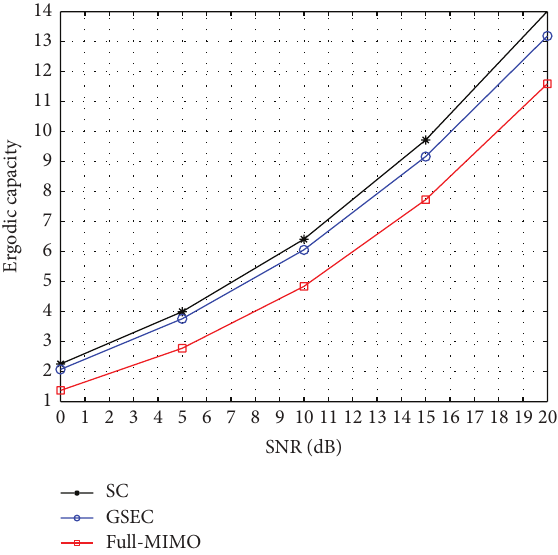
Figure 5: A channel estimation example of GSEC scheme ( 𝑁 𝑅 = 20 , = 4 ). 𝐿 𝑅